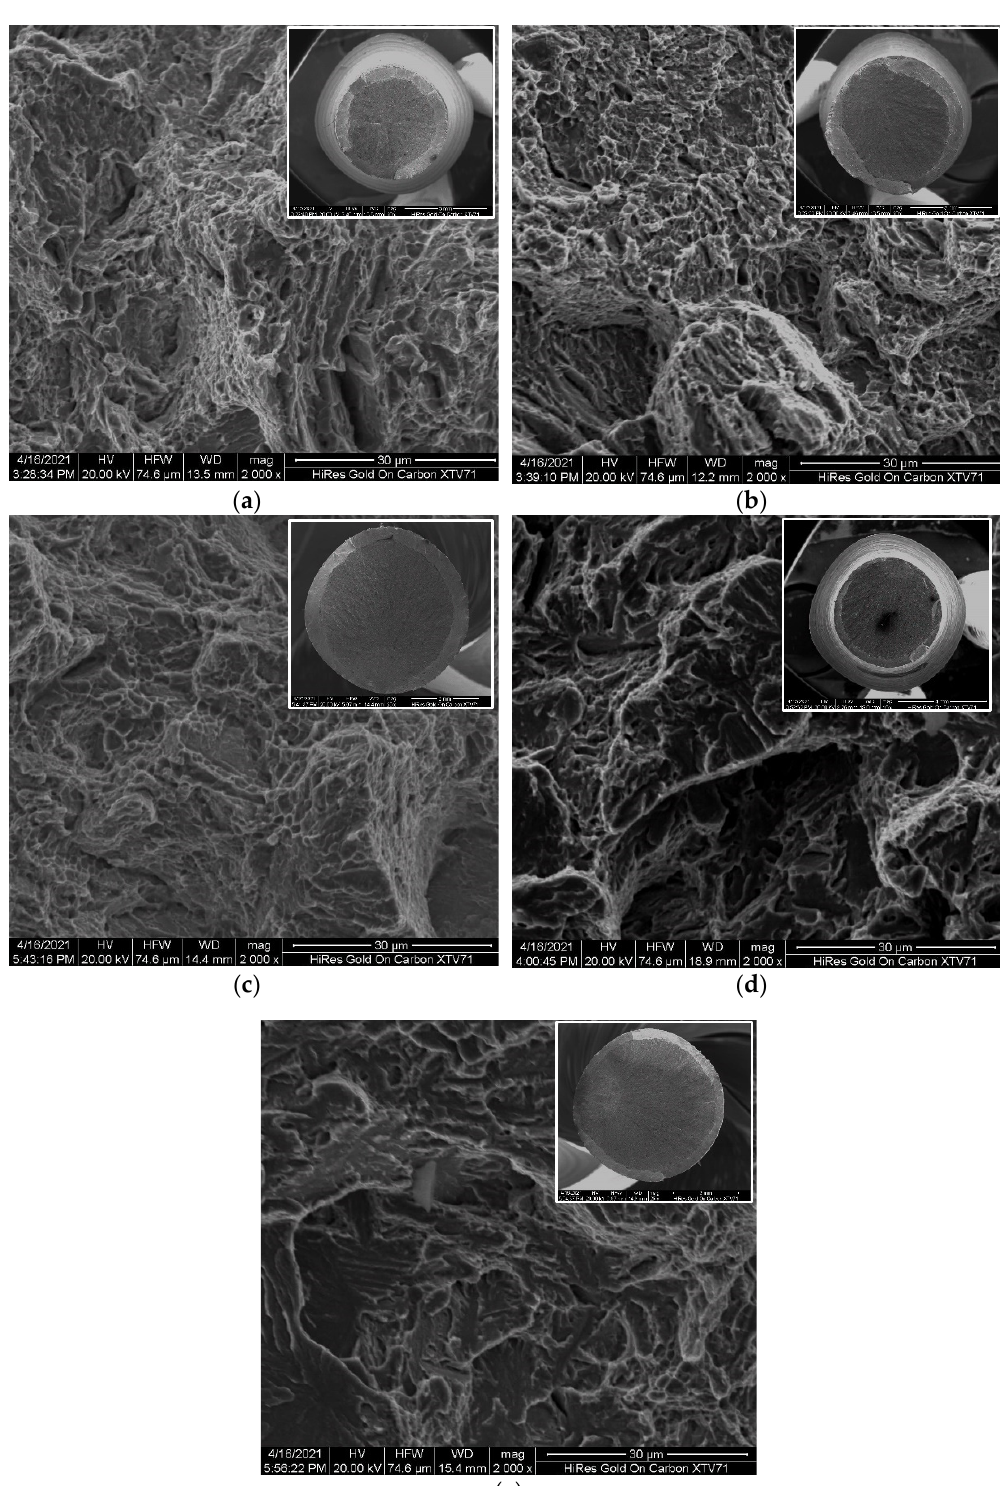
Figure 5. Tensile fracture morphology of material B. ( a ) Normal strain rate tensile test without hydrogen charging; ( b ) Hydrogen filling 0.5 h slow strain rate tensile test; ( c ) Hydrogen filling 1.0 h slow strain rate tensile test; ( d ) Hydrogen filling 1.5 h slow strain rate tensile test; ( e ) Hydrogen filling 2.0 h slow strain rate tensile test.